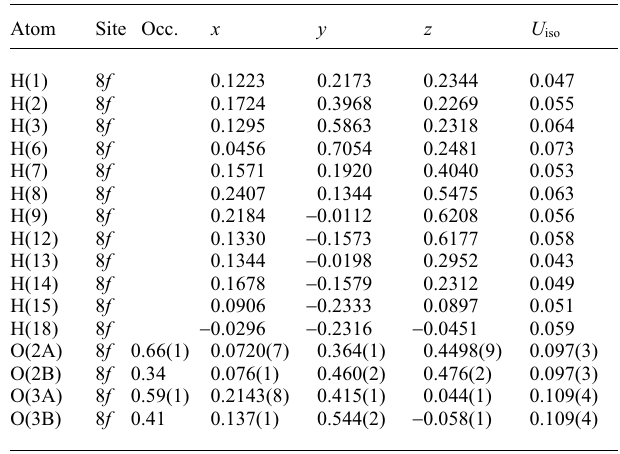
Table 2. Atomic coordinates and displacement parameters (in Å 2 ) .